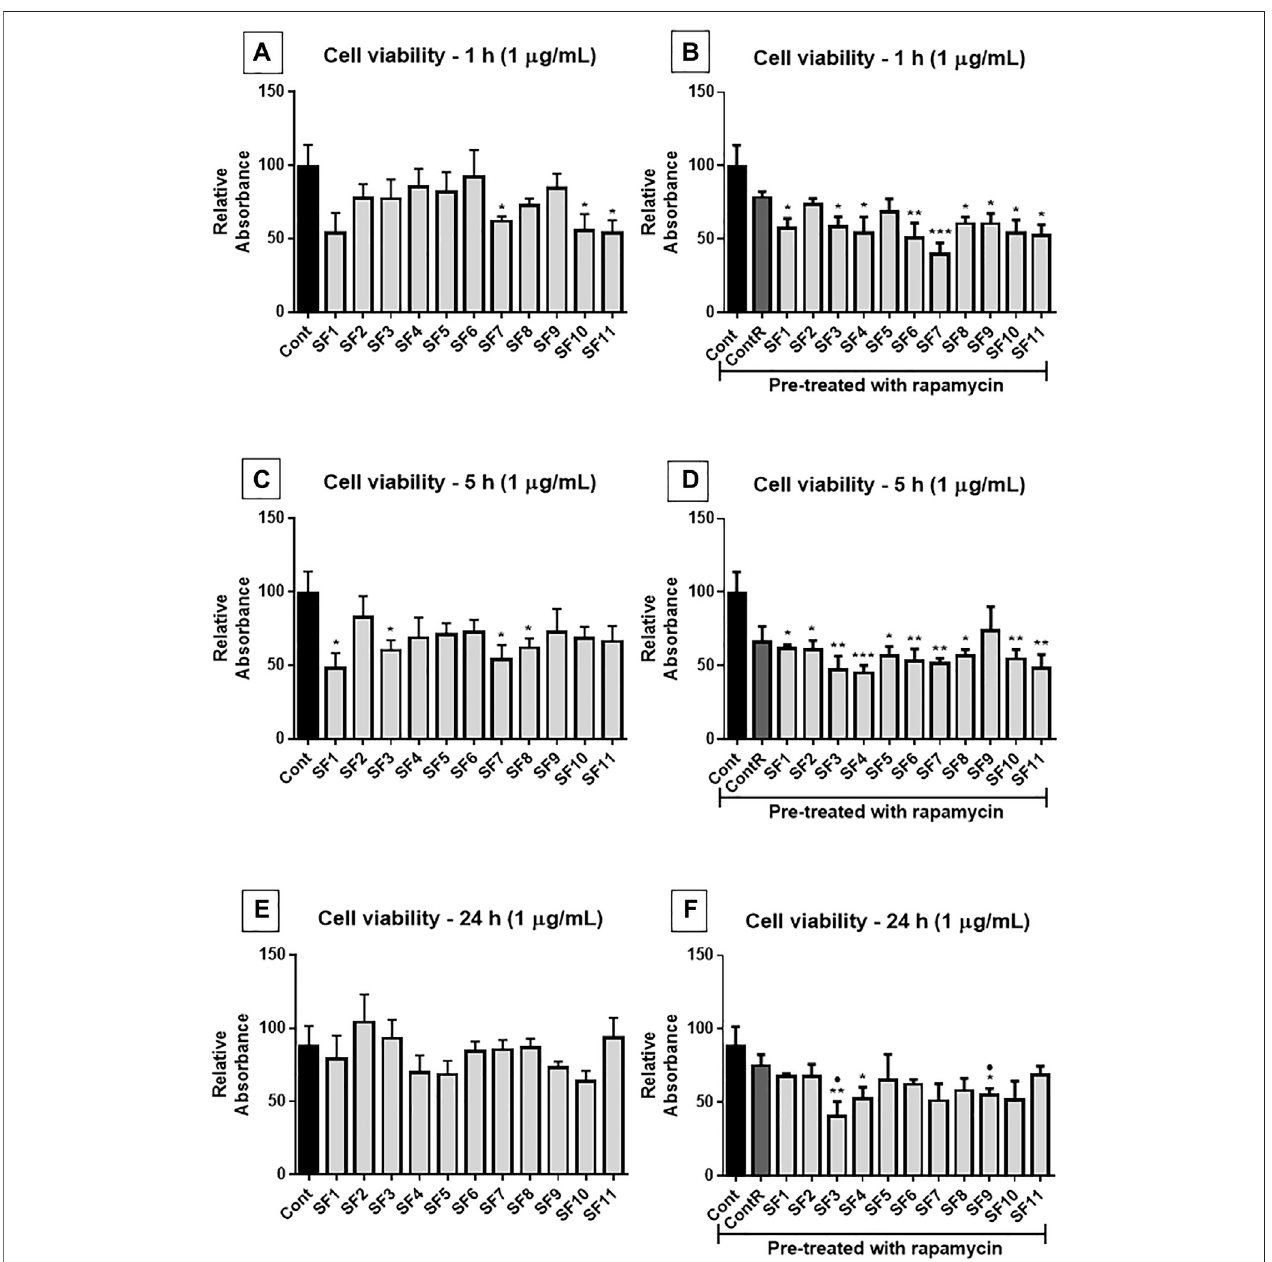
FIGURE7 | Cell viability assay(MTT): human GB cells treated withsubfractions (SF1 toSF11) at 1 μ g/ml, withor without mTOR inhibition withrapamycin. (A) After 1 h of exposure to treatments, SF7, SF10, and SF11 signi fi cantly reduced cell viability. (B) In cells pretreated with rapamycin, all SFs (except SF2 and SF5) signi fi cantly decreasedtheviabilityofcells. (C) 5 hafter treatments,SF1,SF3, SF7,and SF8signi fi cantlyreducedcellviability,and when cellswerepretreated withrapamycin (D) ,all SFs except SF9 signi fi cantly reduced cell viability. (E) 24 h after exposure, no signi fi cant differences were observed, but when mTOR was inhibited (F) , SF3, SF4, and SF9 signi fi cantly reduced cell viability. One-way ANOVA followed by Dunnett ’ s multiple comparisons test; unpaired Student ’ s t-tests were used to compare each treatment with the control. * p < 0.05, ** p < 0.01, compared to the control (Cont); * p < 0.05, compared to the control (Cont).